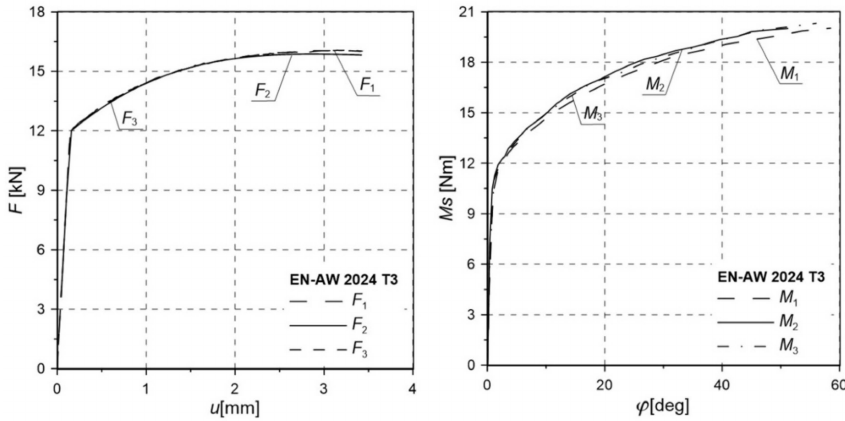
Figure 4. Relationships between tensile force and elongation F ( u ) and torsional moment and torsional angle M ( ϕ ) of the measuring base for smooth specimens.